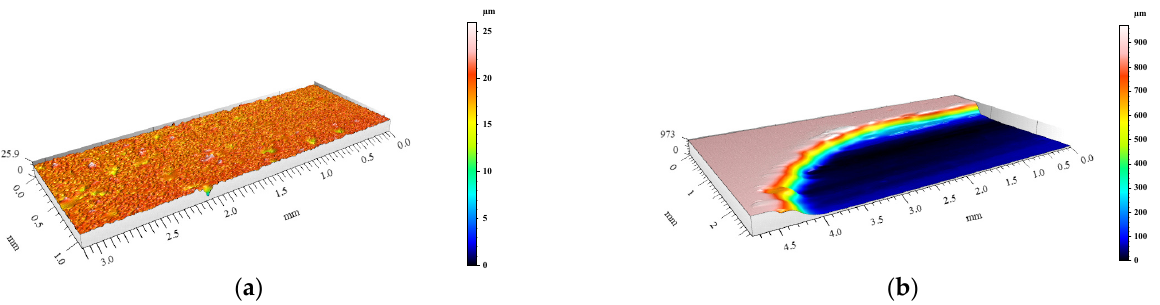
Figure 11. View of AlSi12/GC p composite surface geometry: ( a ) before and ( b ) after dry friction test.